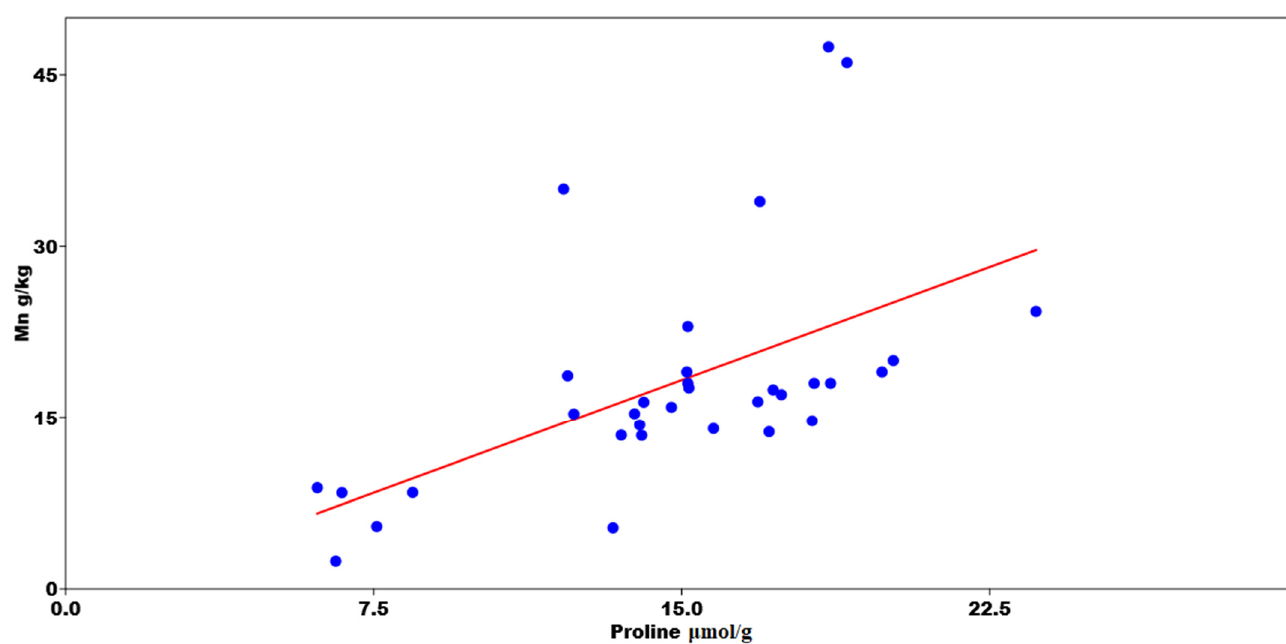
Figure 3. Results of multivariate regression between proline (Pro) concentration and Mn content.